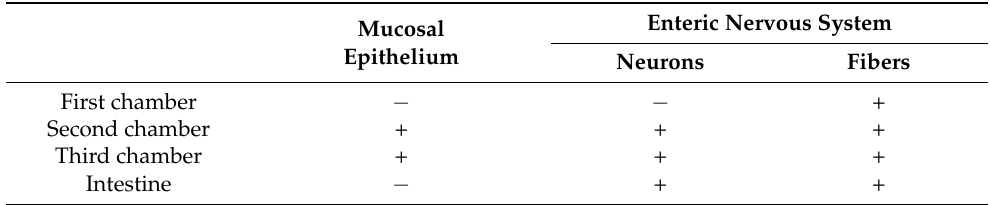
Table 1. Summary of immunolocalization of Nesf-1 in the gastrointestinal tract of common bot- tlenose